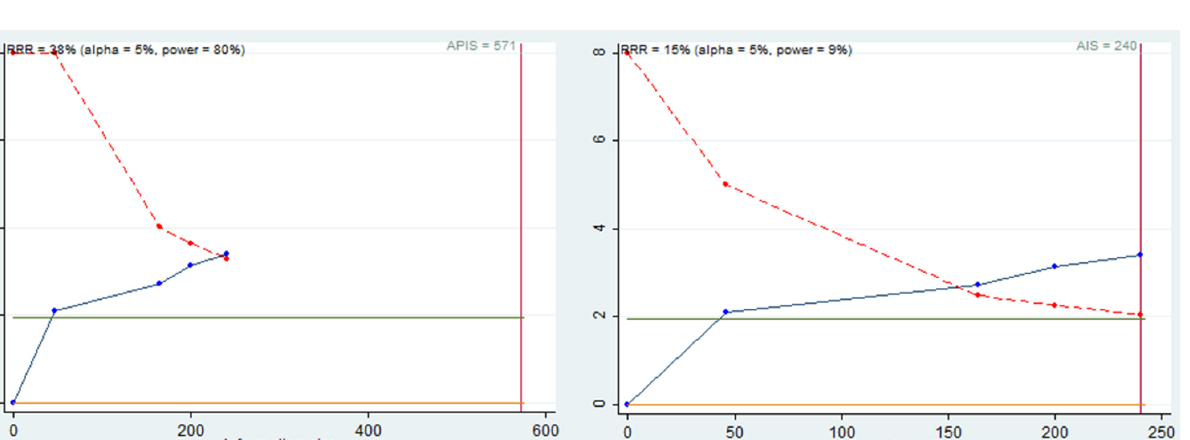
Table 4. Evaluation of GRADE pro-GDT.